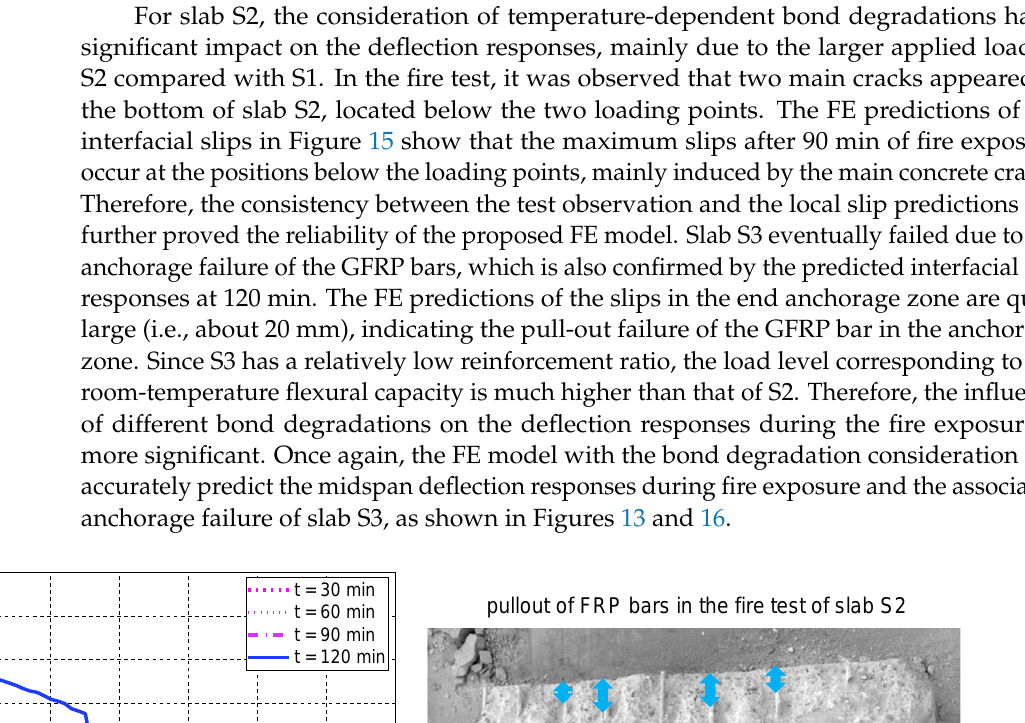
Figure 14. Interfacial slip distributions along the GFRP bar length of S1.